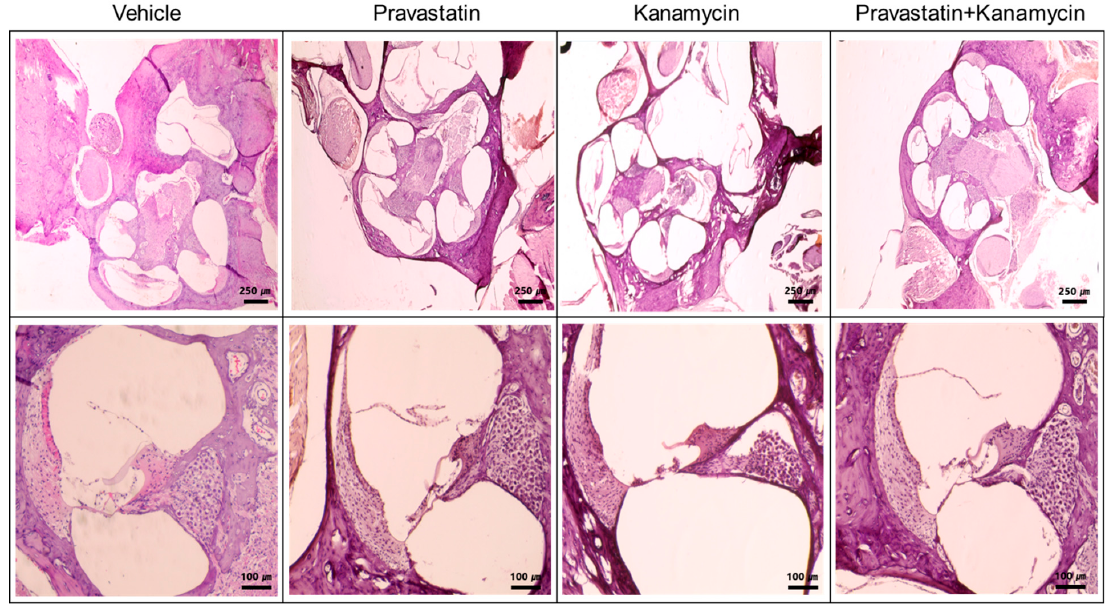
Figure 2. H&E staining of cochleae. The cochleae of the KM group demonstrated loss of outer hair cells and spiral ganglion cells, whereas the cochleae of the PV + KM group showed preserved spiral ganglion cells.